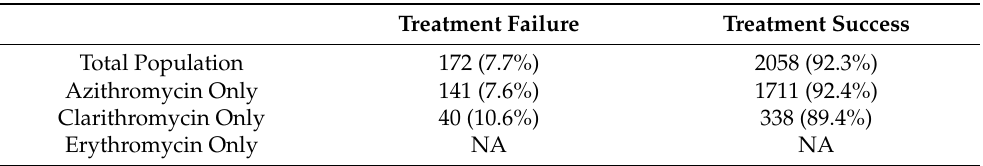
Table 4. Summary of the macrolide treatment failure rates within the bacteria-specific pneumonia analysis for the total study population and broken down by macrolide used. Data are presented as absolute number, as well as percentage.